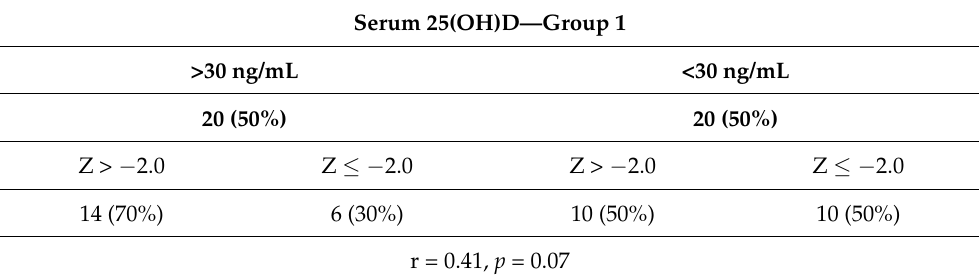
Table 7. The prevalence of BMD Z-score value alterations in patients with normal and decreased levels of serum 25(OH)D (group 1).